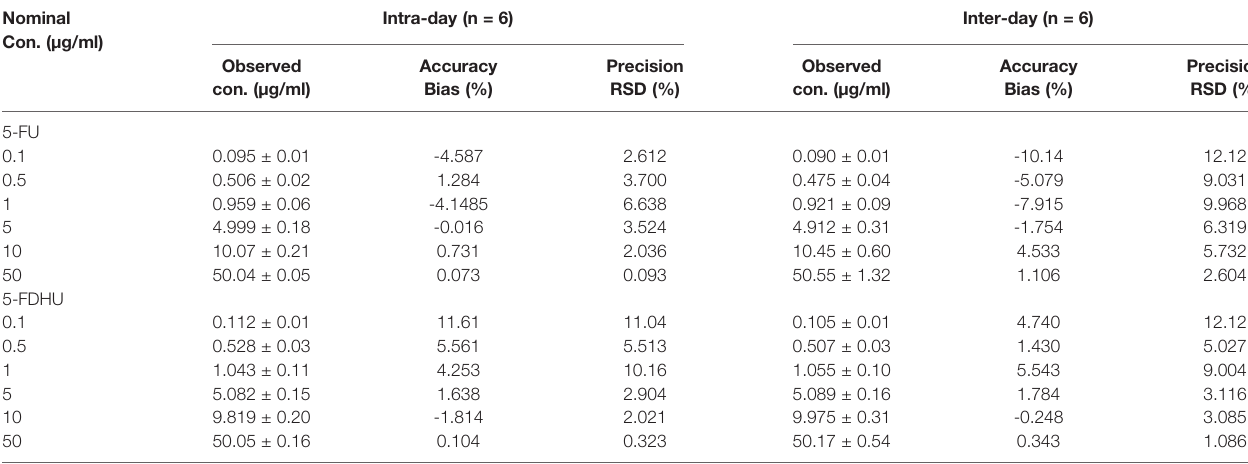
TABLE 3 | Inter-day and intra-day assay precision (% RSD) and accuracy (% Bias) values for the HPLC-UV method for the determination of 5-FU and 5-FDHU in rat plasma. Nominal Con. (µg/ml)